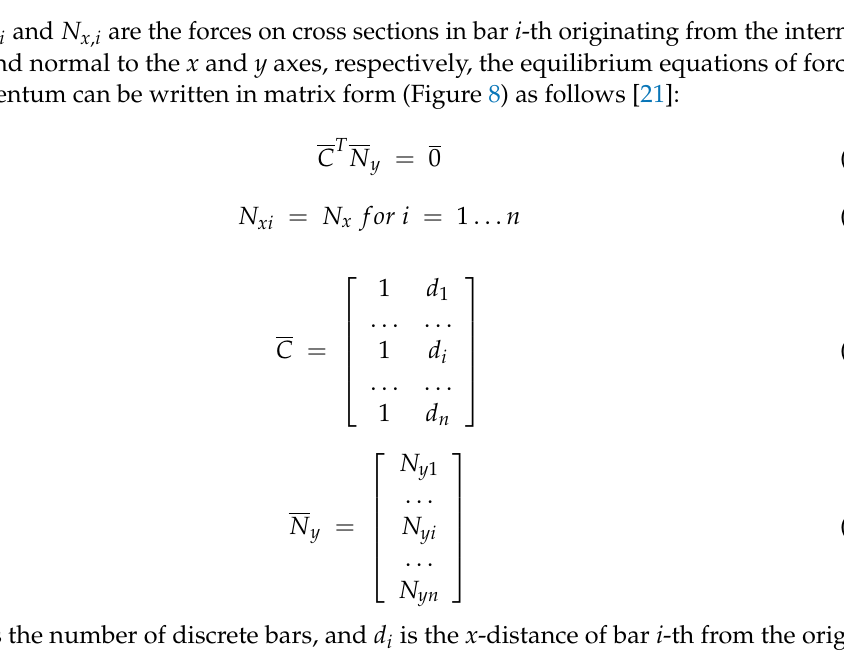
Figure 8. Schematic representation of the welded plates with lateral constraints and weld line highlighted in red.